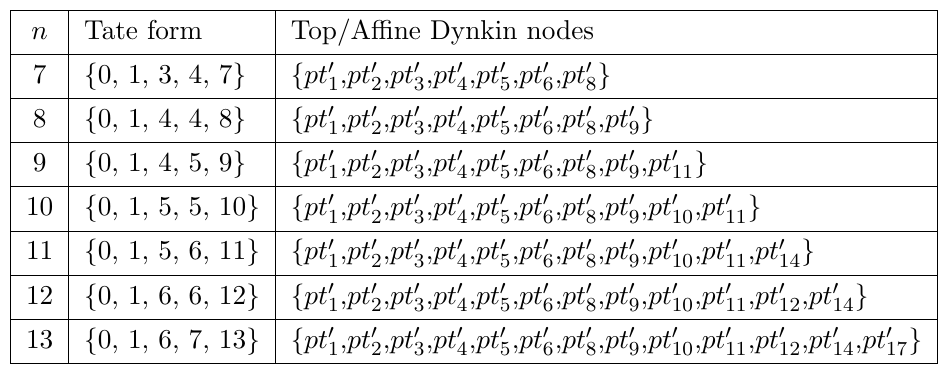
Table 7. The tops of su ( n ) algebras. The coordinates of the points pt are given in equations (4.4) and (4.5). All lattice points in these tops are of level one, and